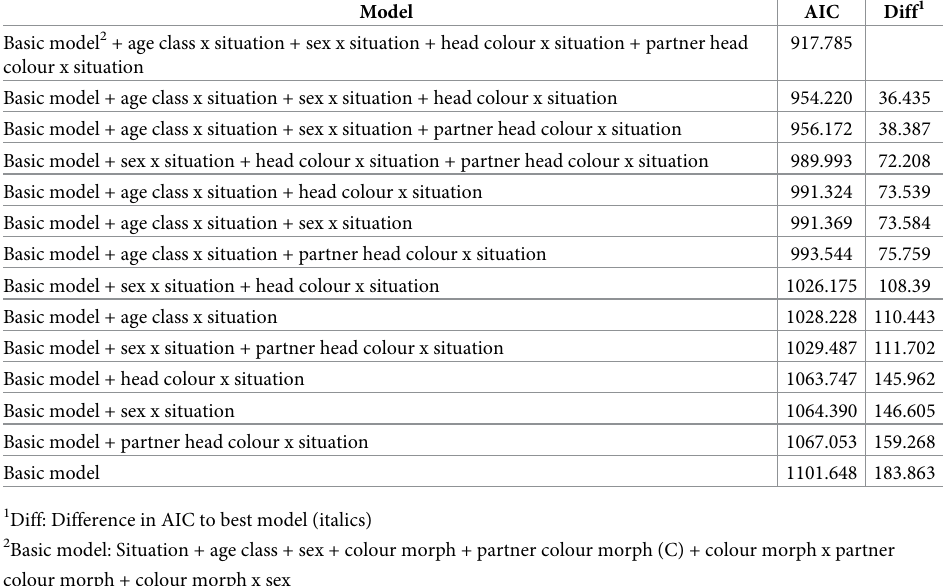
Table 1. Model selection outcome using Akaike information criterion (AIC) comparing vigilance in Gouldian finches with respect to head colour, partner head colour, age class and sex in different situations.